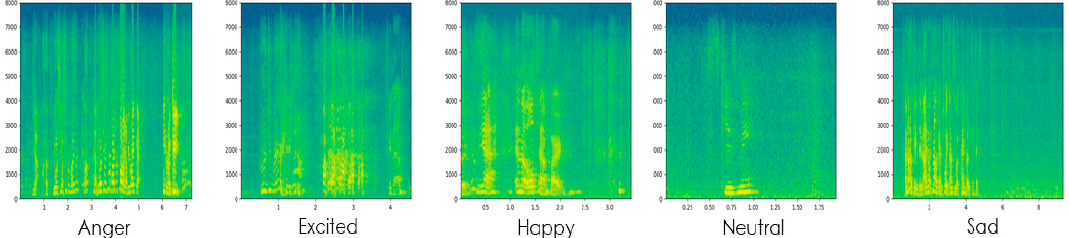
Figure 2. Visual representations of speech signal in 2D spectrograms of various emotions.